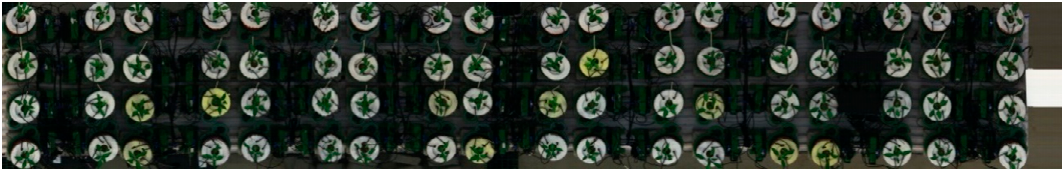
Figure 3. RGB image of 72 pepper plants on a table in the greenhouse. The camera movement was from right to left, starting with the white reference panel for exposure time calibration.